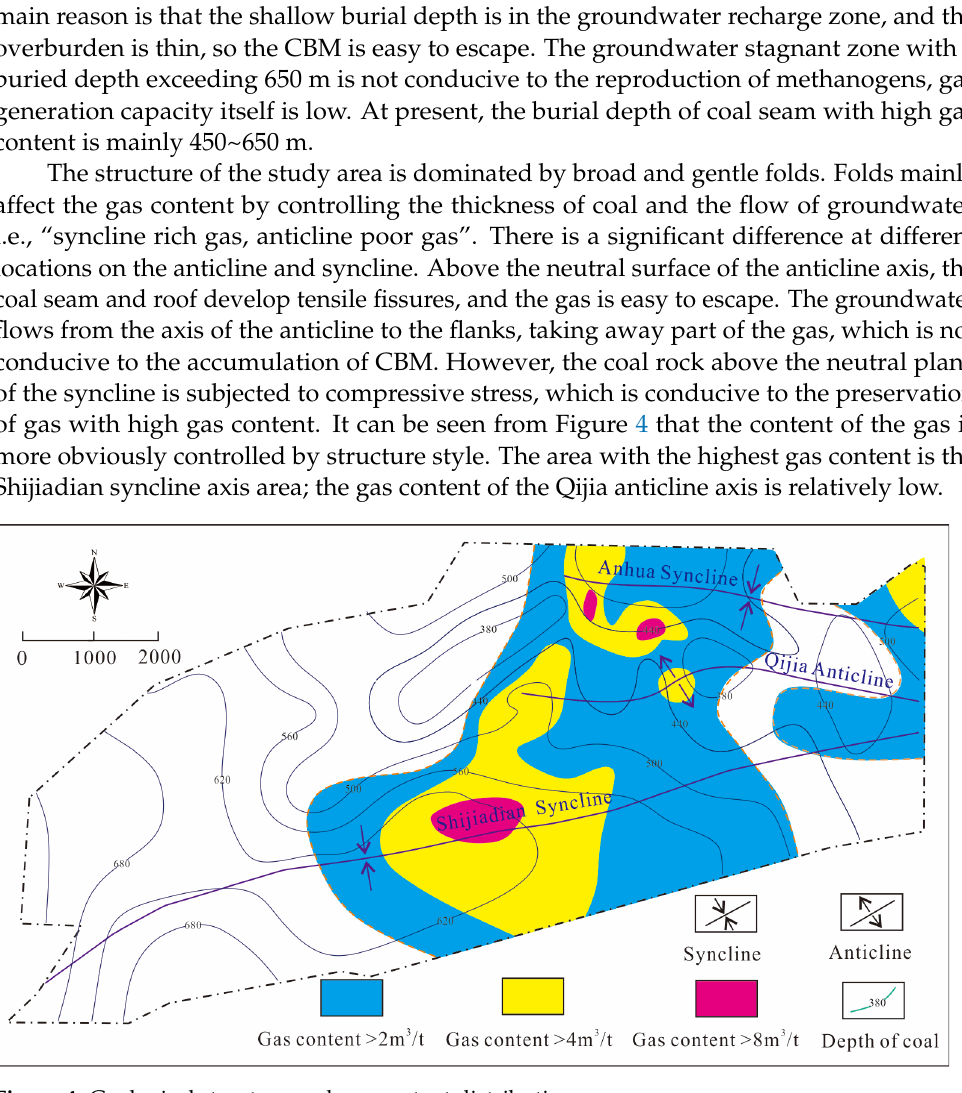
Figure 4. Geological structure and gas content distribution.